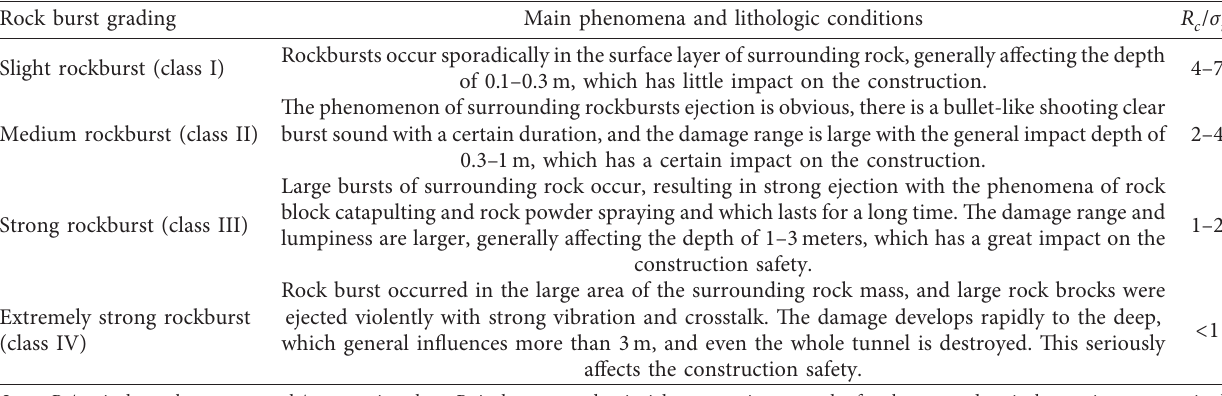
Table 1: Classification of rockbursts [31].